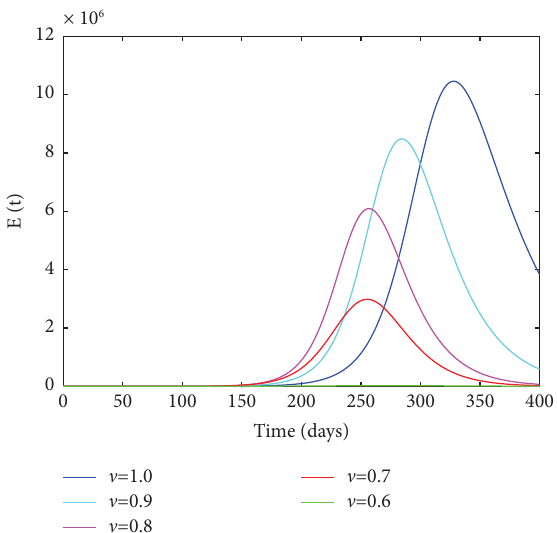
Figure 3: Behaviour of the exposed individuals at diferent values of v